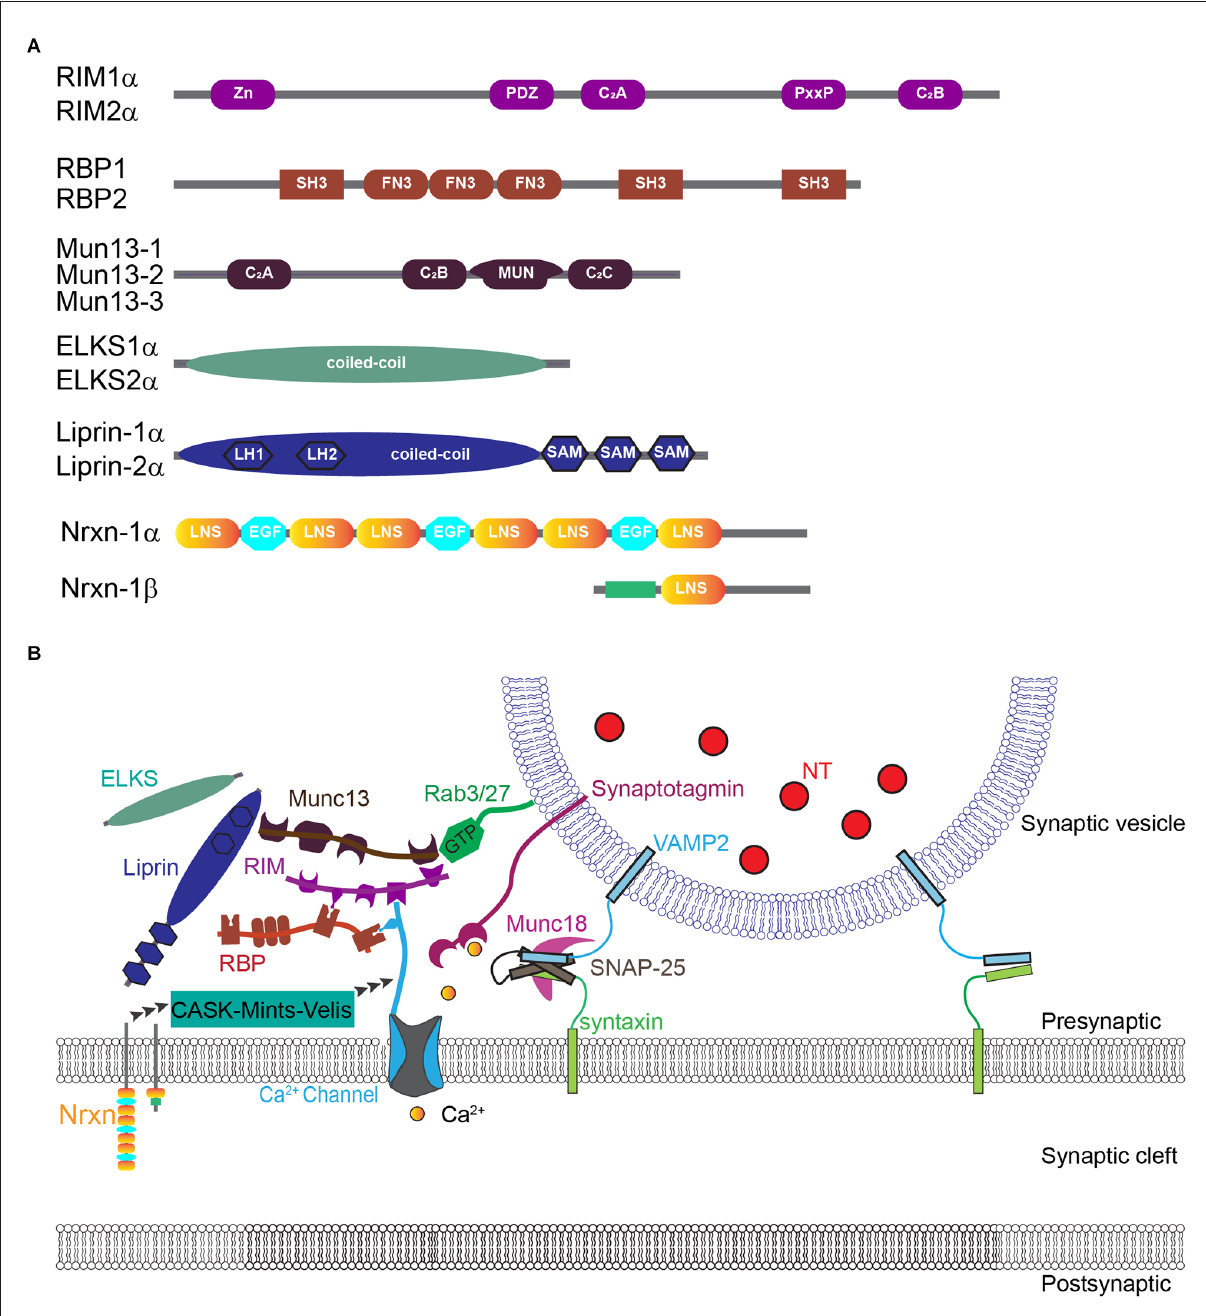
FIGURE2 Molecular organization of CaV2 channels at the presynaptic active zone. (A) Diagram of domain structures of evolutionarily conserved key active zone proteins. (B) Model of nanoscale organization of CaV channels interacting with complex active zone proteins and synaptic vesicles. Adapted with permission from Südhof